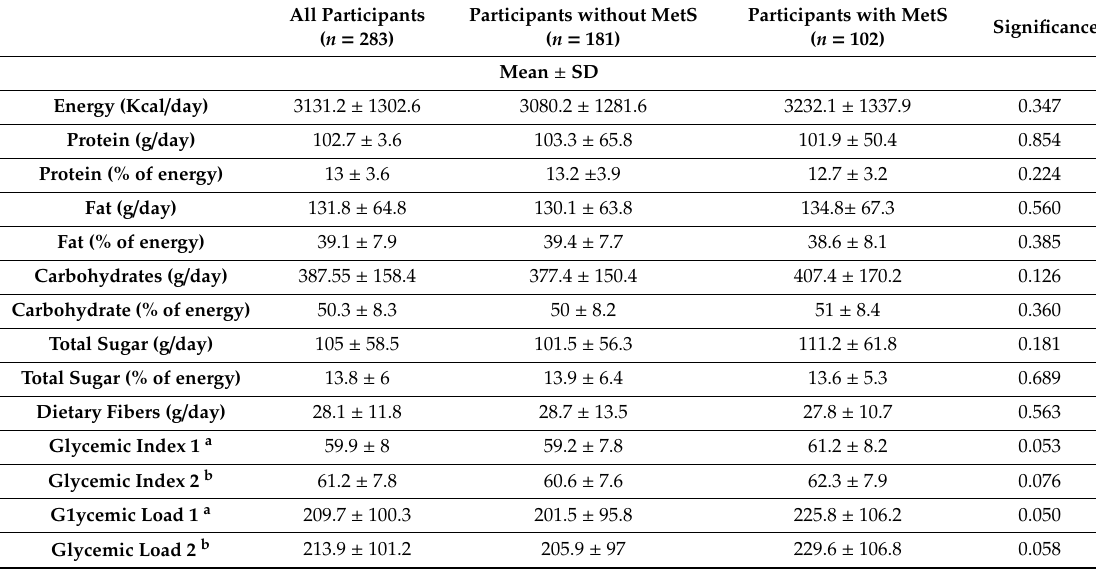
Table 2. Dietary energy, macronutrients, GI, and GL of participants with and without MetS. All Participants Participants without MetS Participants with MetS Significance ( n = 283) ( n = 181) ( n = 102) Mean ±